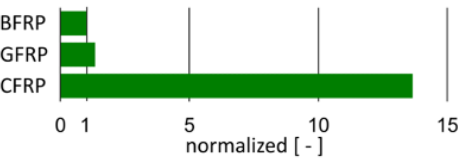
Figure 4. Comparison of the GWP of di ff erent FRPs (normalized